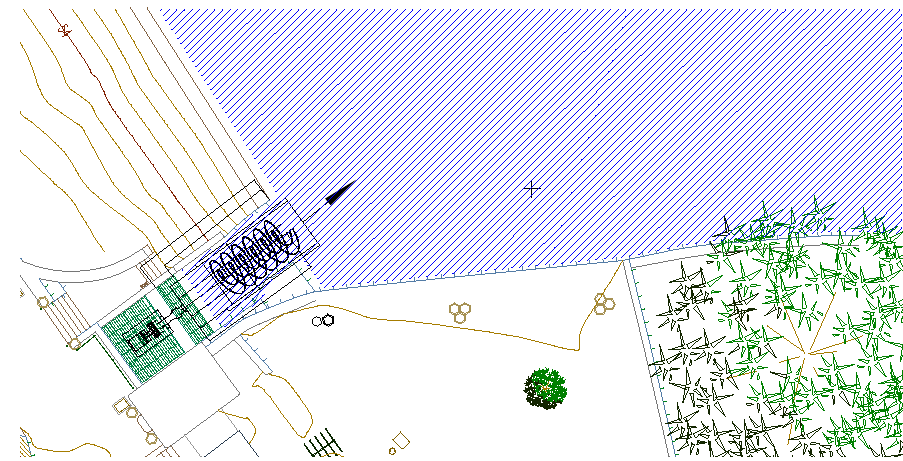
Figure 9. AST schematic installation–top